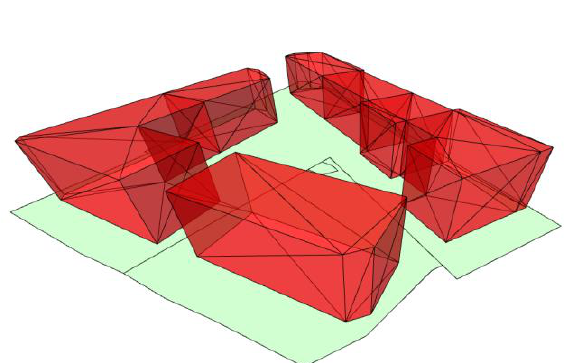
Figure 8 . CityGML constructed from building